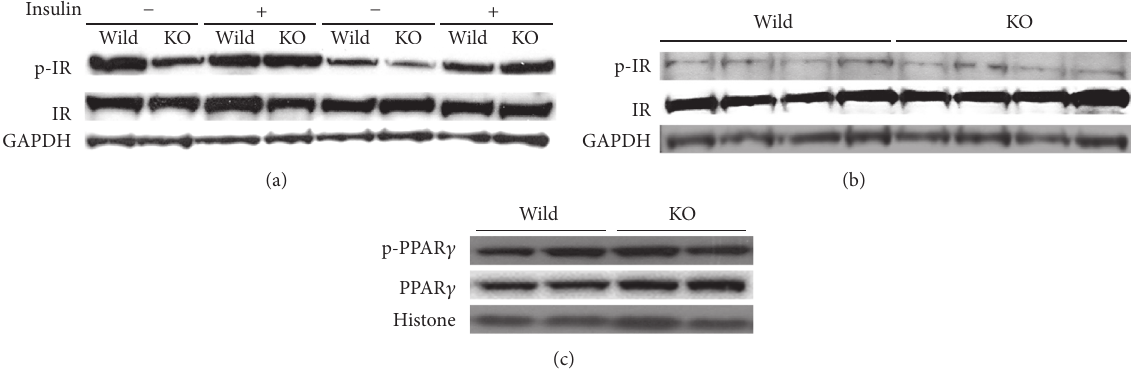
Figure 5: The activation of insulin signaling pathways and PPAR 𝛾 phosphorylation in Mig-6 f/f and Mig-6 d/d mice. The activities of insulin signaling were measured by western blotting using anti-p-IR, anti-IR, and anti-GAPDH antibodies. (a) In the liver (fasting or insulin injection after fasting condition). (b) In the reproductive fat (fasting condition). (c) PPAR 𝛾 phosphorylation measured by western blotting using anti- p-PPAR 𝛾 , anti-PPAR 𝛾 , and anti-histone antibodies in reproductive fat.